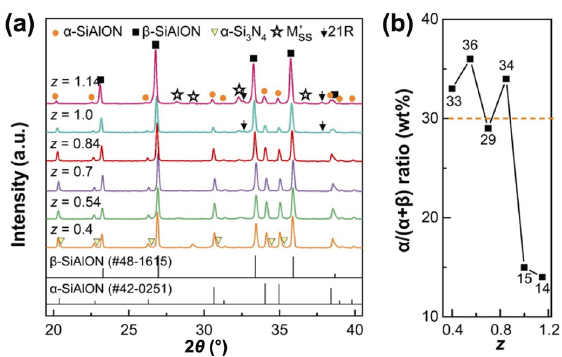
Fig. 4 (a) XRD patterns (M' SS : aluminum-containing melilite phase, Y 2 Si 3  x Al x O 3+ x N 4  x ; 21R: AlN polytypoid, SiAl 6 O 2 N 6 ), and (b) α /( α + β ) ratio of the α / β -SiAlON ceramics with different z values ( m = 1.7, n = 1.0, synthesized at 1750 ℃ ).